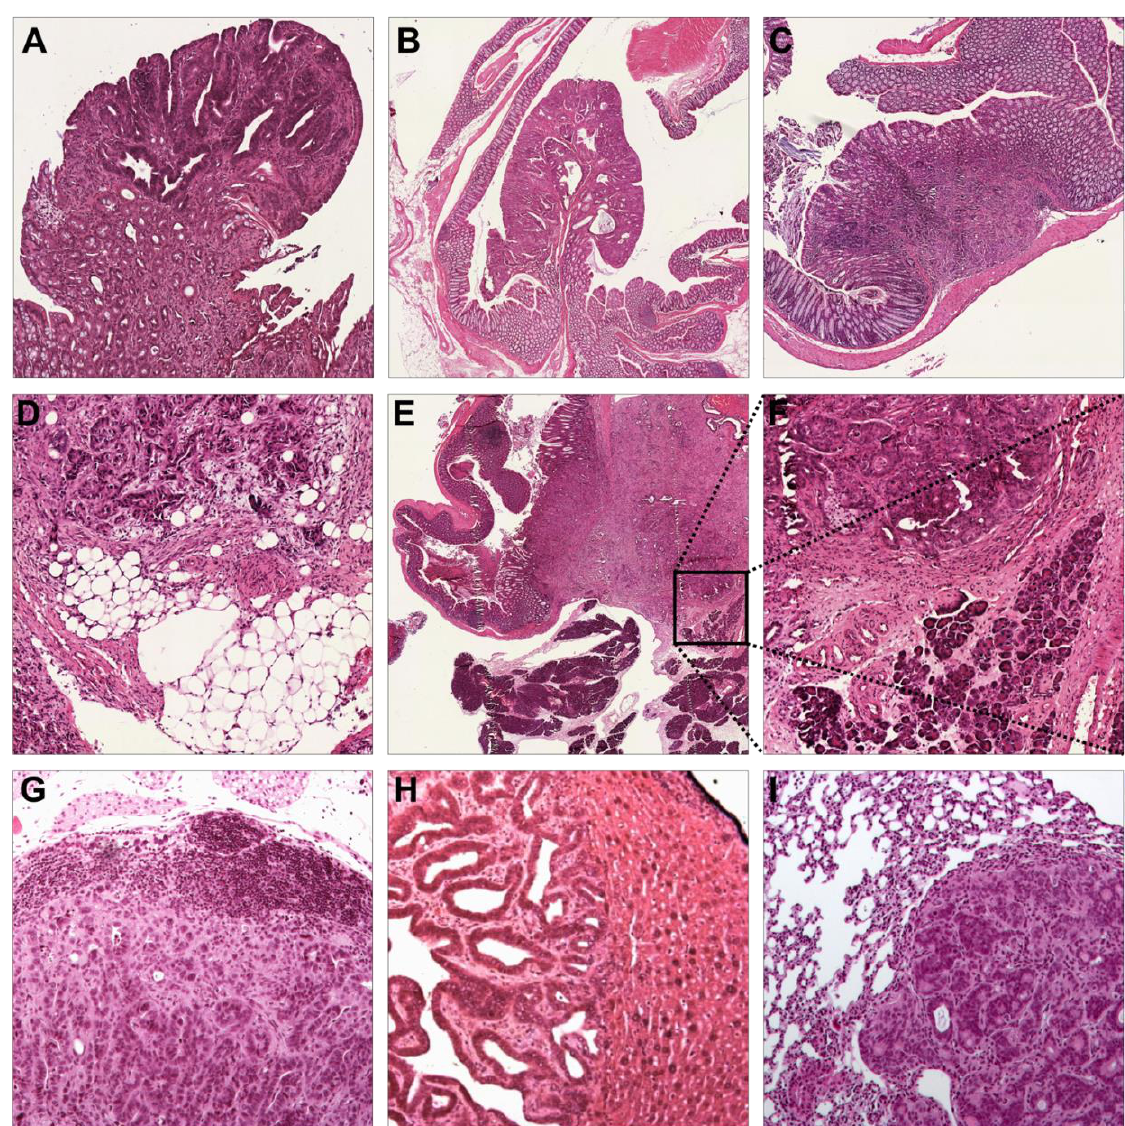
Figure 2. Histopathology analysis confirms the invasiveness and metastatic potential of the mouse model. ( A ). Villous adenoma (Apc, 4 × ). ( B ) Tubular adenoma (AK, 2 × ). ( C ) Focally invasive adenocarcinoma invading the submucosa (T1b sm3, AK, 4 × ). ( D ) Scirrhous adenocarcinoma invading pericolic adipose tissue (T4, AKPfl, 10 × ). ( E ) Locally advanced, scirrhous adenocarcinoma invading pancreatic acinar tissue (T4, AKPfl, 2 × ). ( F ) Magnification (10 × ) of E . ( G ) Mesenteric lymph node metastasis (AKPr, 10 × ). ( H ) Liver metastasis (AKPr, 10 × ). ( I ) Lung metastasis (AKPr, 10 × ). Apc, Apc fl/fl mice; AK, Apc fl/fl /Kras LSL-G12D/+ mice; AKPr, Apc fl/fl /Kras LSL-G12D/+ /Trp53 LSL-R172H/+ mice;